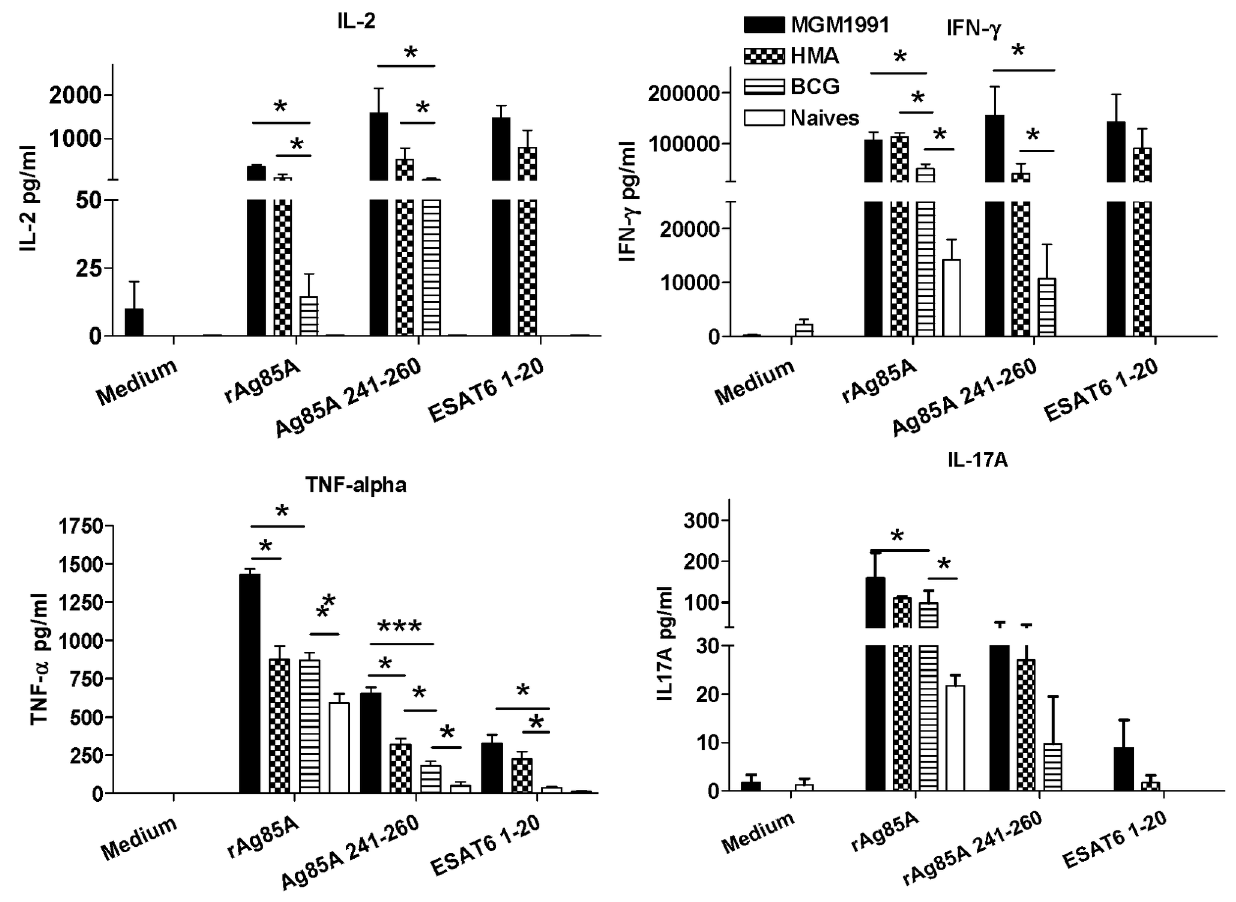
Figure 1. Spleen cell cytokine production in mice vaccinated with MGM1991, HMA or BCG vaccine. IL-2, IFN-γ, TNF-α and IL-17A levels in spleen cell culture supernatant of C57BL/6 mice vaccinated 4 weeks before with 5x10 4 CFU of MGM1991, HMA or M. bovis BCG by the subcutaneous route or from unvaccinated (naïve) mice and stimulated in vitro with recombinant Ag85A (5 µg/ml) or with I-A b restricted immunodominant peptides spanning aa 241-260 of Ag85A or aa 1-20 of ESAT-6 (10 µg/ml). Cytokine levels are expressed in pg/ml (mean ± SD of 5 mice tested